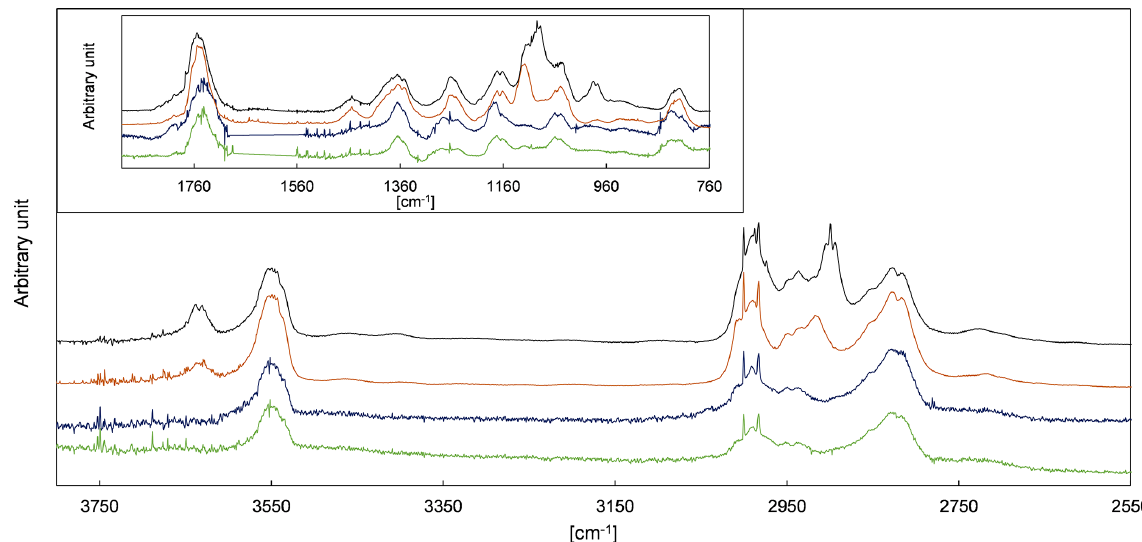
Figure 5. FTIR spectra of the residuals assigned to 2HPr obtained in the 1080L chamber (green) and 480L chamber (blue) 3P2 + OH experiments and residuals obtained from the ozonolysis of 3-penten-2-ol (brown) and 3-buten-2-ol